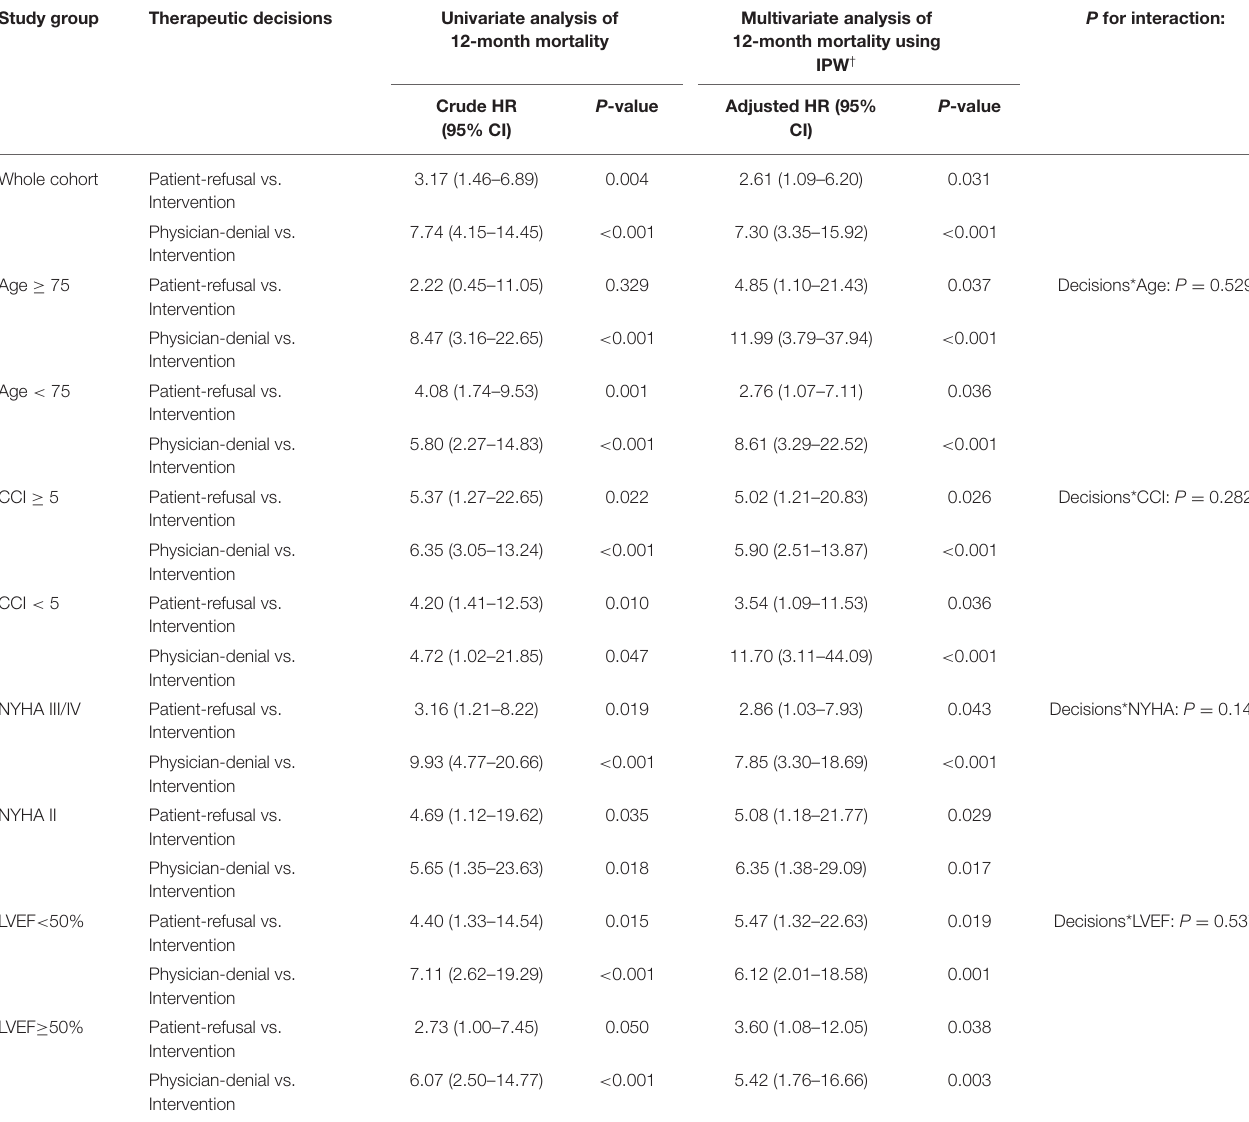
TABLE 3 | Association of therapeutic decisions with 12-month mortality. Study